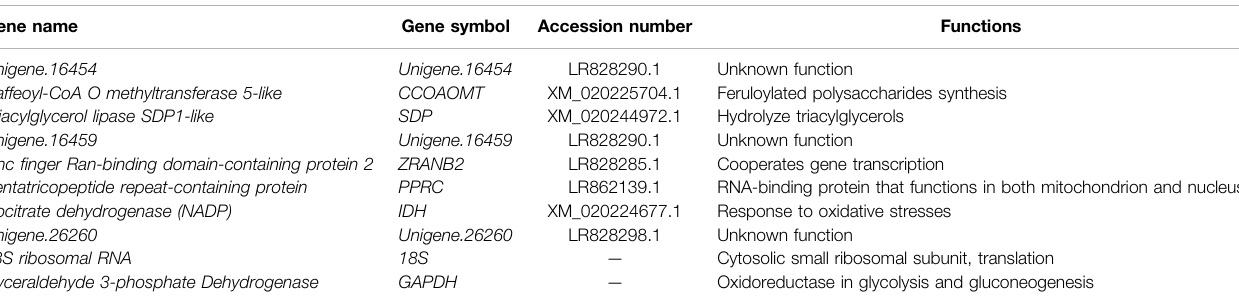
TABLE 2 | Description of candidate reference